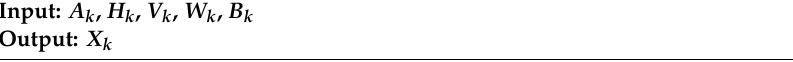
Table 2. The KF prediction